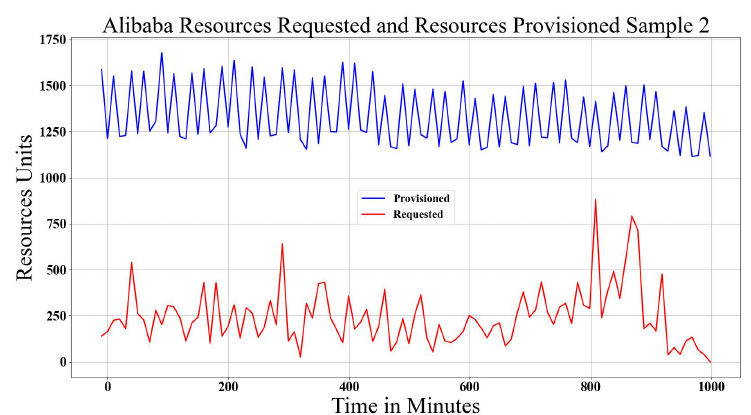
Figure 6. Alibaba data center Provisioned and Requested Resources, Sample